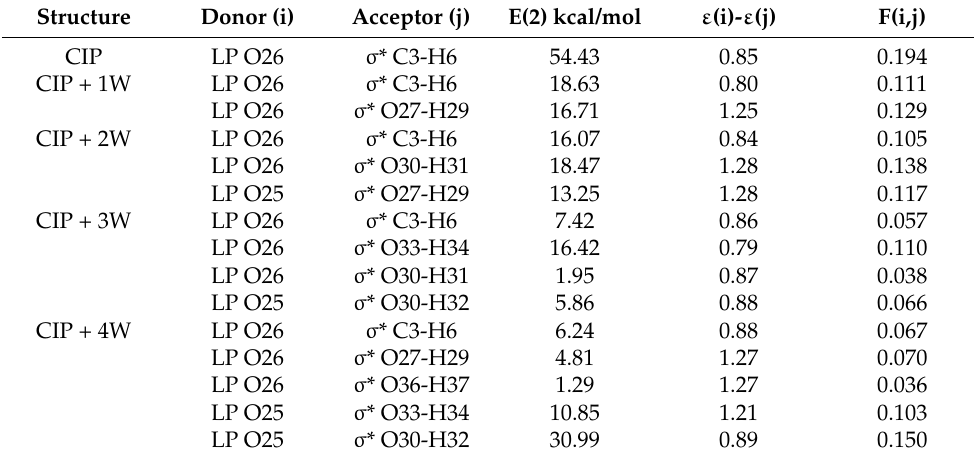
Table 2. The main electron donor–acceptor interactions in the EmimOAc- n H 2 O conformers and